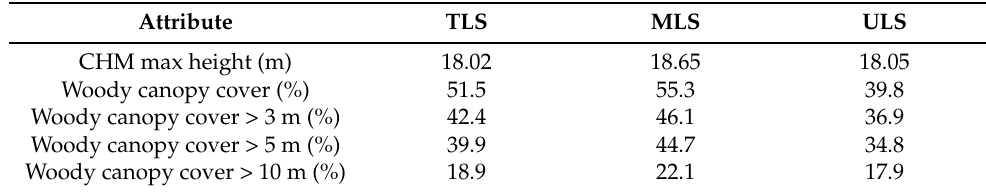
Table 2. Summary statistics of woody canopy attributes collected by the three LiDAR systems at the 1 ha plot scale.